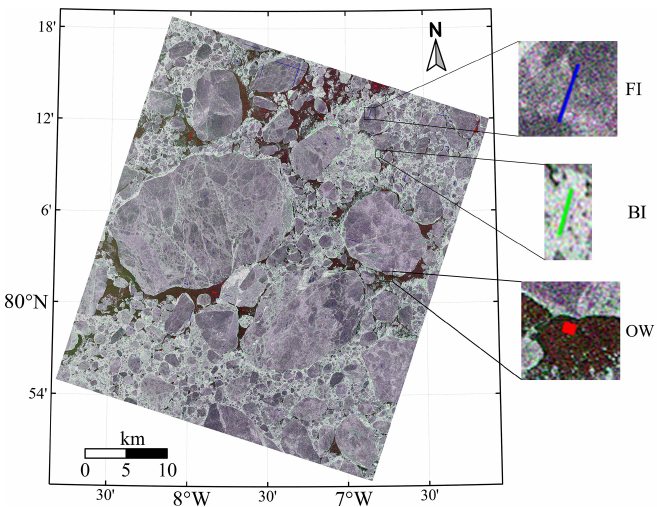
Figure 3. Examples of the labeled areas from the training scene of the composite image of R3-16 with three amplified segments: blue: floe ice, green: brash ice, red: open water. For each pixel in the labeled area of each type, the pixel and its neighboring pixels in the composite SAR image were extracted as a patch. Each patch was considered to represent a single surface type, i.e., the type of the center pixel. Figure 4 depicts a virtual segment in an image, with the three colors representing the three surfaces of FI, BI, and OW. For instance, the black outer boundary represents the labeled area, with all the pixels inside representing the FI surface. For each pixel within the labeled area, a window is established. This is shown in the dotted lines for pixels “a”, “b”, “c”, and “d”. The